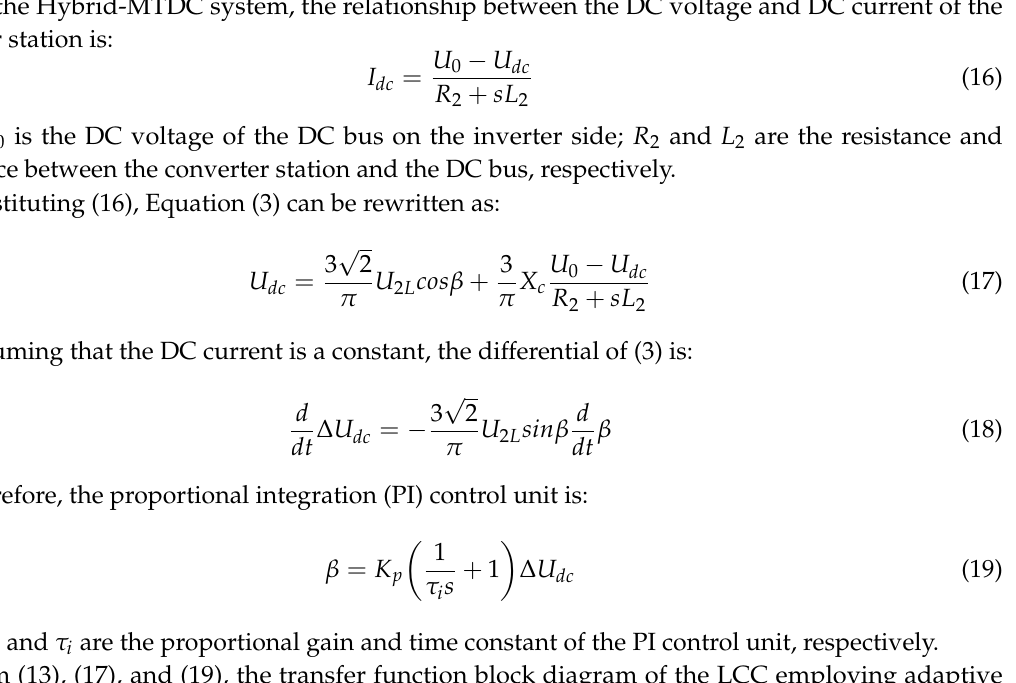
Figure 10. Steady-state DC equivalent circuit of the four-terminal hybrid HVDC system.